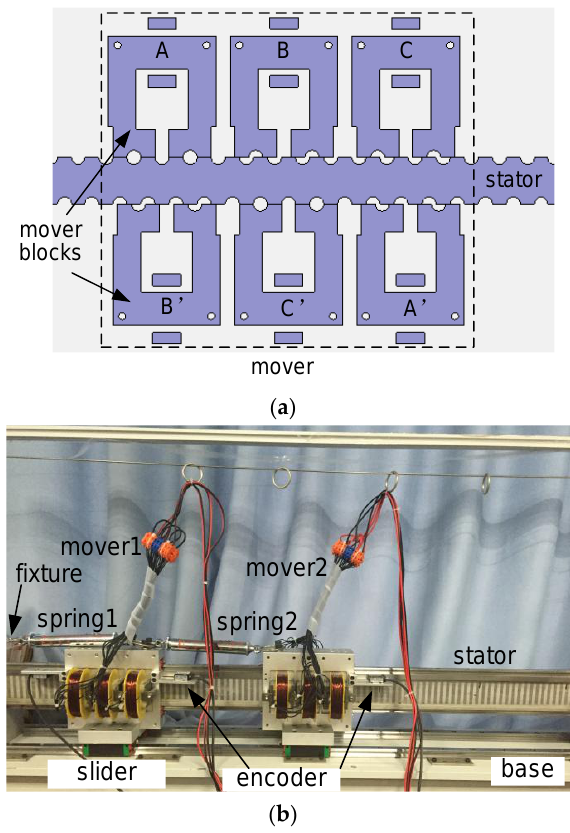
Figure 1. ( a ) Machine topology of the linear machine ( b ) picture of the dual-mover linear switched reluctance machine (LSRM). Table 1. Major Specifications of the dual-mover LSRM.